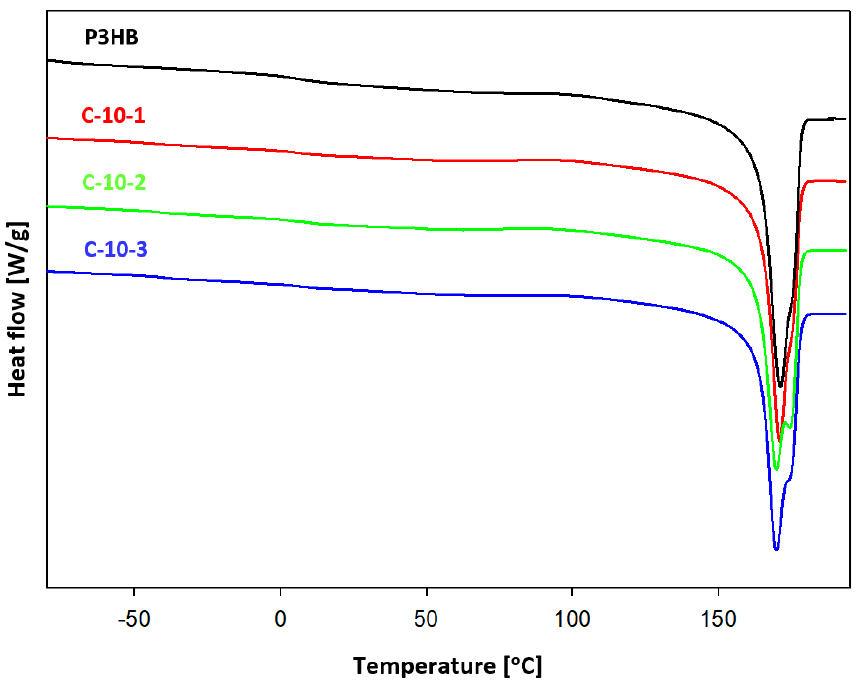
Figure 5. Comparison of heat flow rate of P3HB and its nanobiocomposites with PU400 and Cloisite ® 30B as a function of temperature (designated as C-10-1, C-10-2, and C-10-3, respectively).